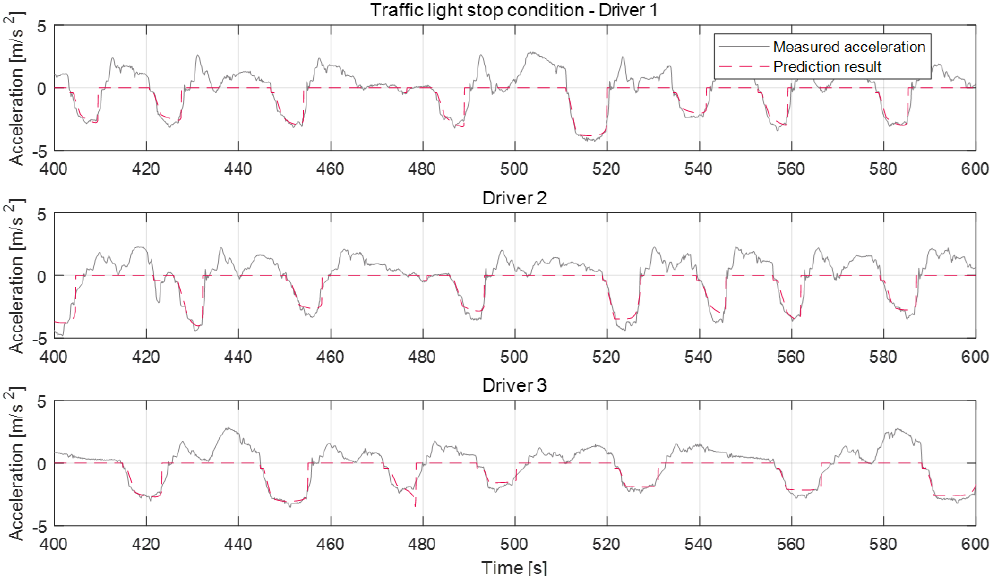
Figure 16. Deceleration prediction results on traffic-light stop condition.